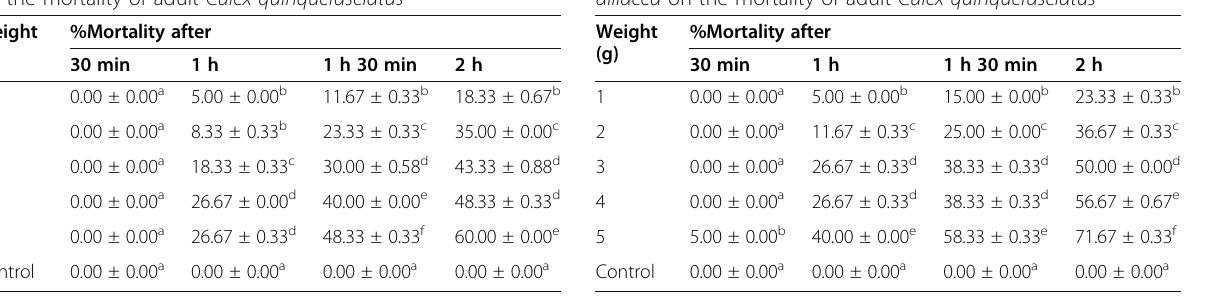
Each value is the mean ± standard error of three replicates. Mean followed by the same alphabet are not significantly ( P > 0.05) different from each other using Duncan ’ s new multiple range test